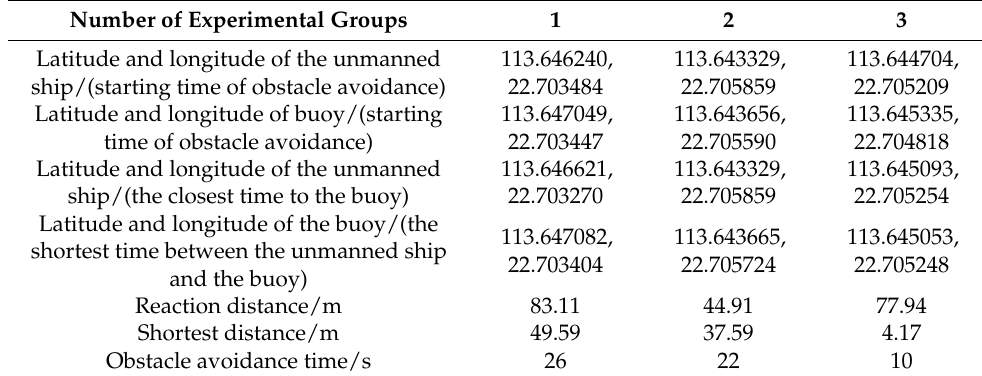
Table 9. Basic measurement data for obstacle avoidance of unmanned ships in cross-encounter scenarios. Number of Experimental